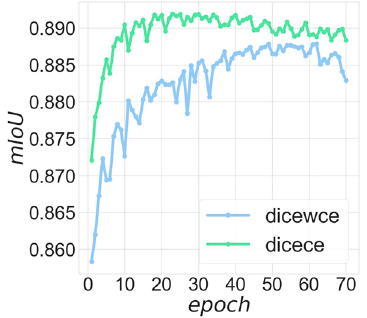
Figure 3. Convergence of the computed mIoU using validation sample. Table 1. Summary of accuracy results using the test sample.